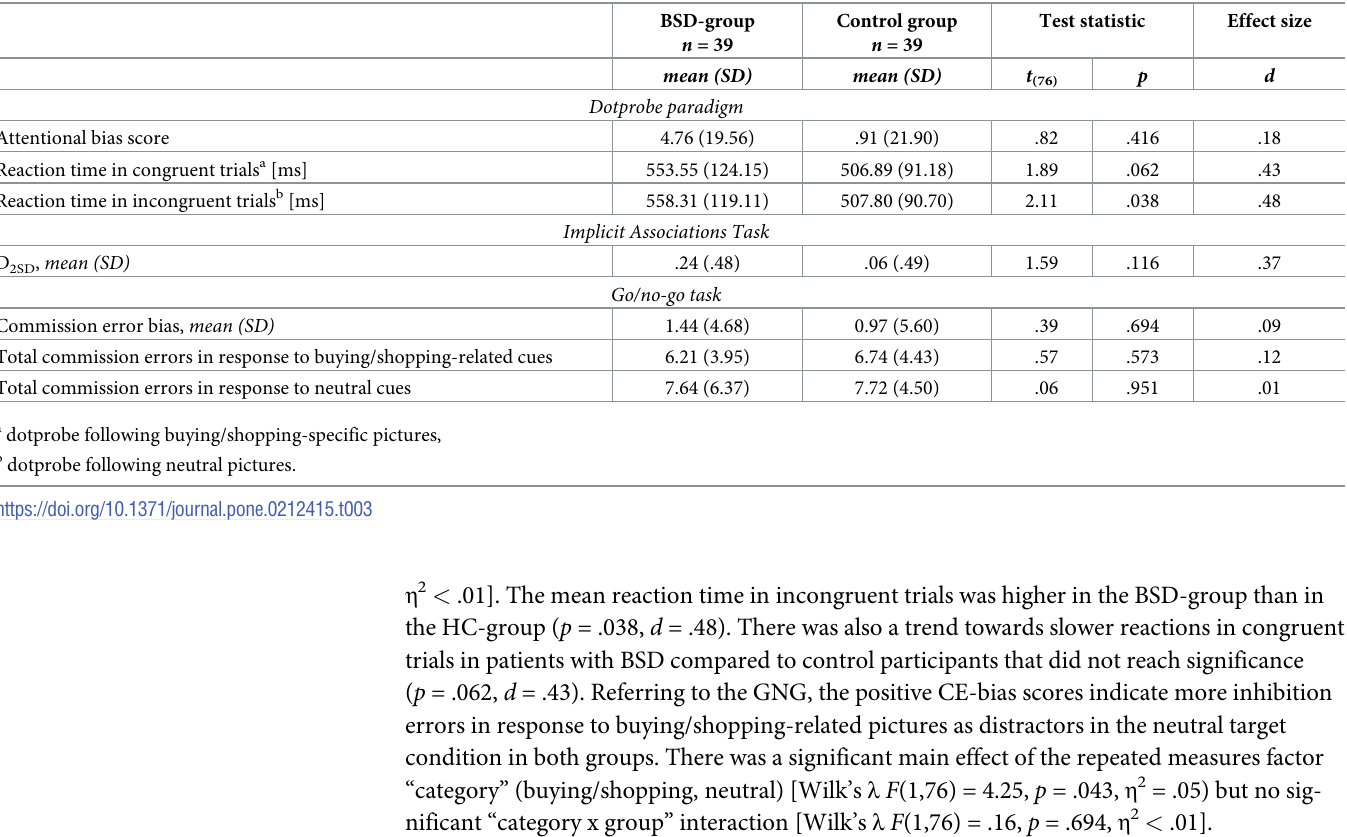
Table 3. Experimental task performance of patients with buying-shopping disorder (BSD) compared to control